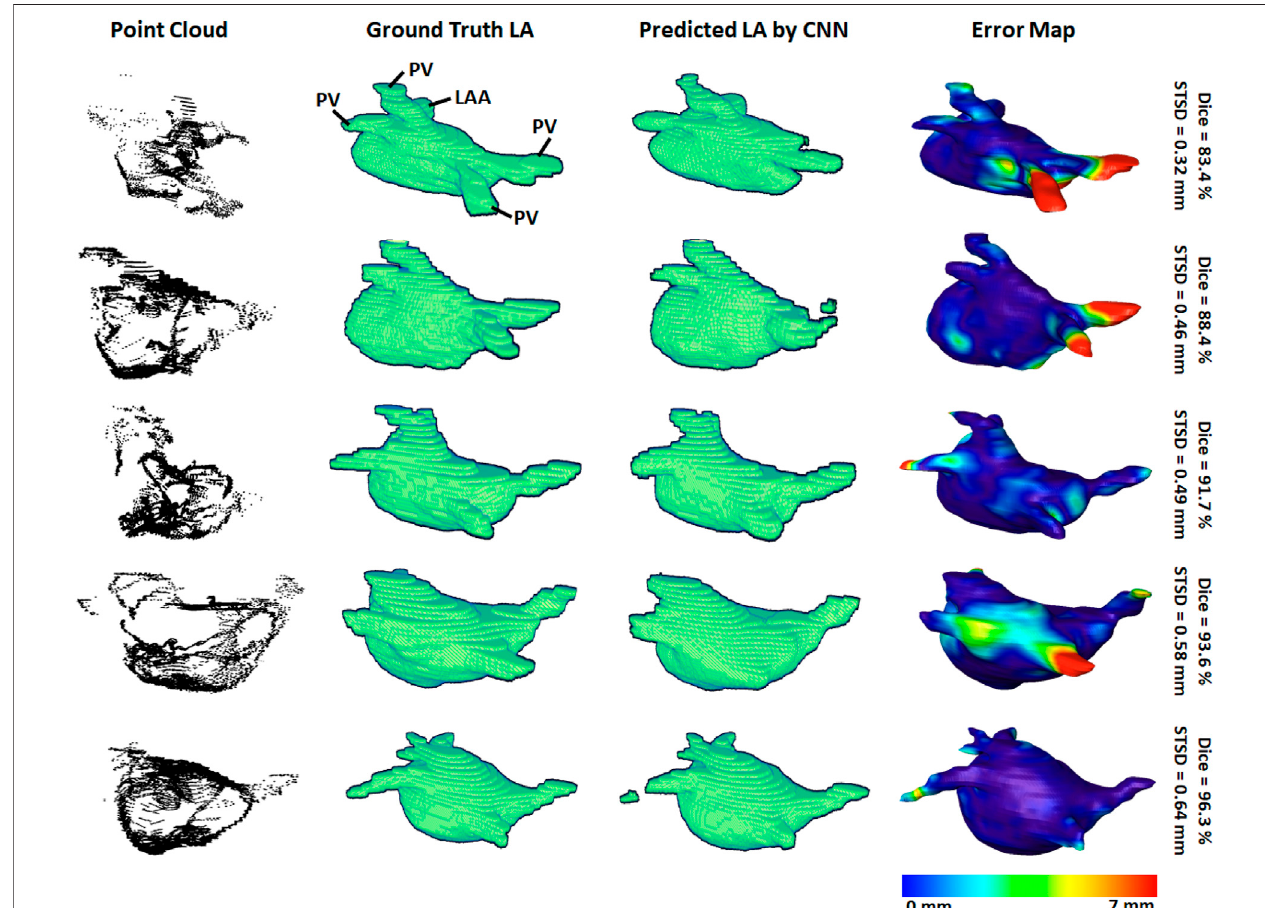
FIGURE3| 3Dvisualizationsoftheleftatrial(LA)reconstructionsof fi vesamplesinthepaired trainingdataset.Thereconstructionswiththehighestdicescoresare in the bottom row and the top row contains the reconstructions with the lowest dice scores. The point-clouds inputs are shown in the fi rst column. The ground truths obtained by manually segmenting the LGE-MRIs are shown in the second column. The reconstructions predicted by the convolutional neural network (CNN) are shown in the third column. The surface-to-surface distance (STSD) error maps between the ground truths and the predictions are shown in the fourth column, with the colors being normalized between 0 and 7 mm for the fi ve samples. LAA, left atrial appendage; PV, pulmonary vein.